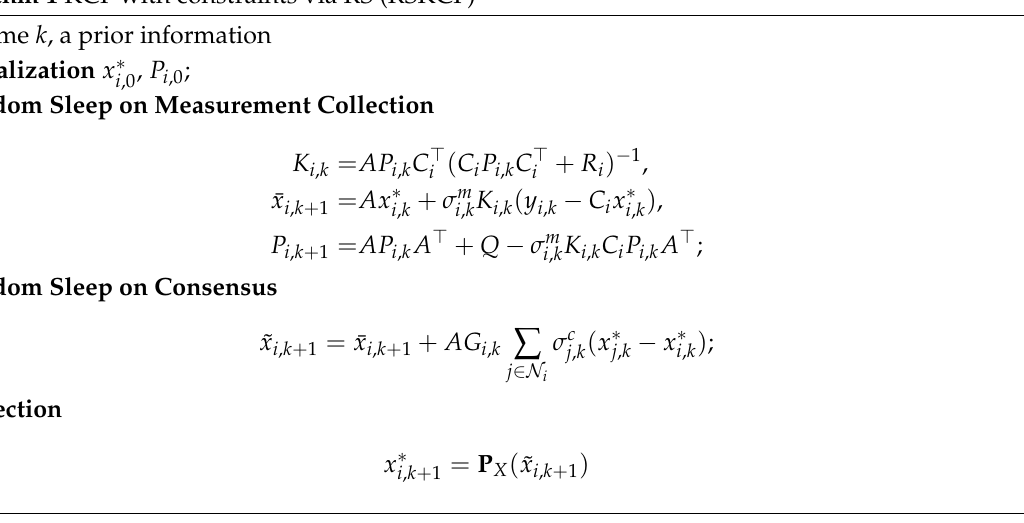
Algorithm 1 KCF with constraints via RS